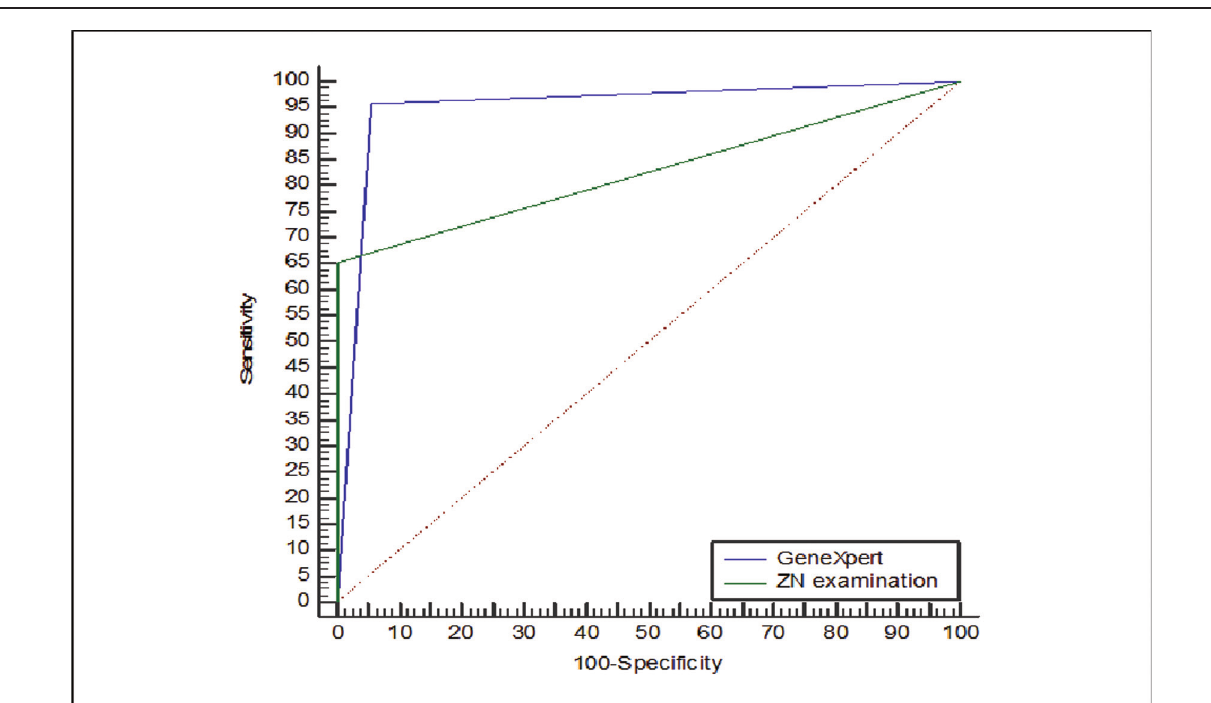
Accuracy of GeneXpert test and ZN examination in diagnosing pulmonary TB. TB, tuberculosis; ZN, Ziehl –